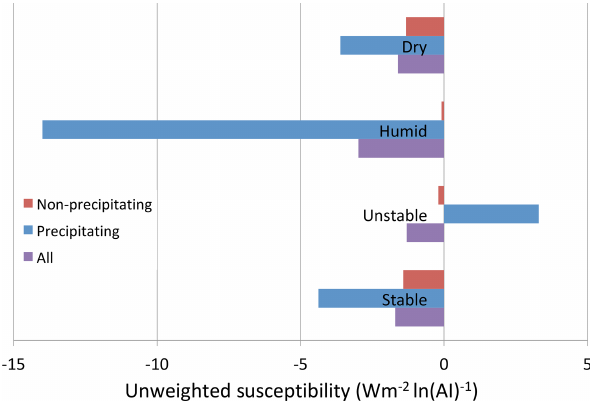
Figure 5. Globally summed and relatively weighted susceptibilities for different conditions when found within regimes of EIS, RH, and LWP on a regional